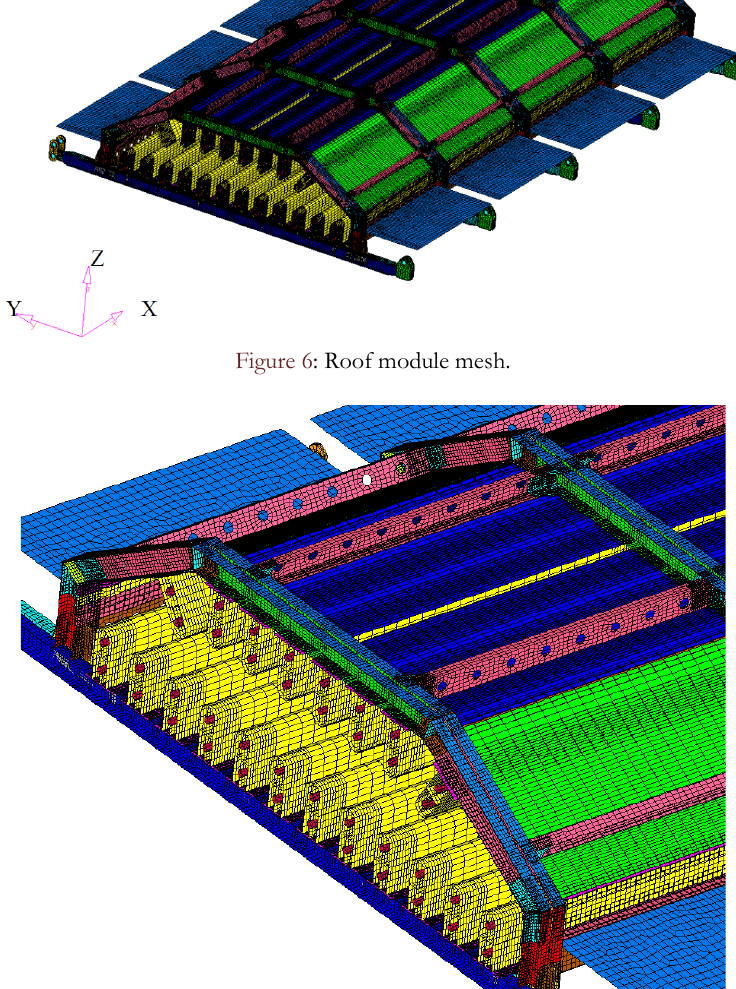
Figure 7: Roof module mesh (detailed